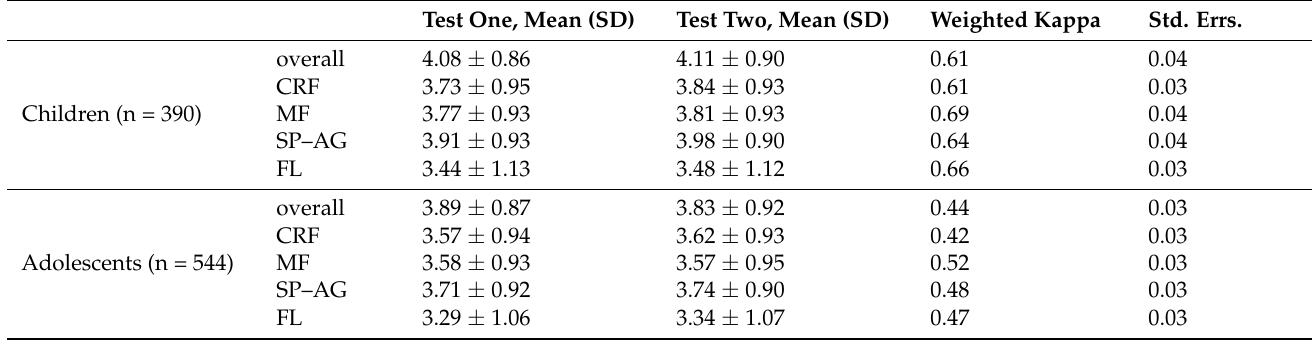
Table 3. Weighted kappa of International Fitness Scale in children and adolescents.